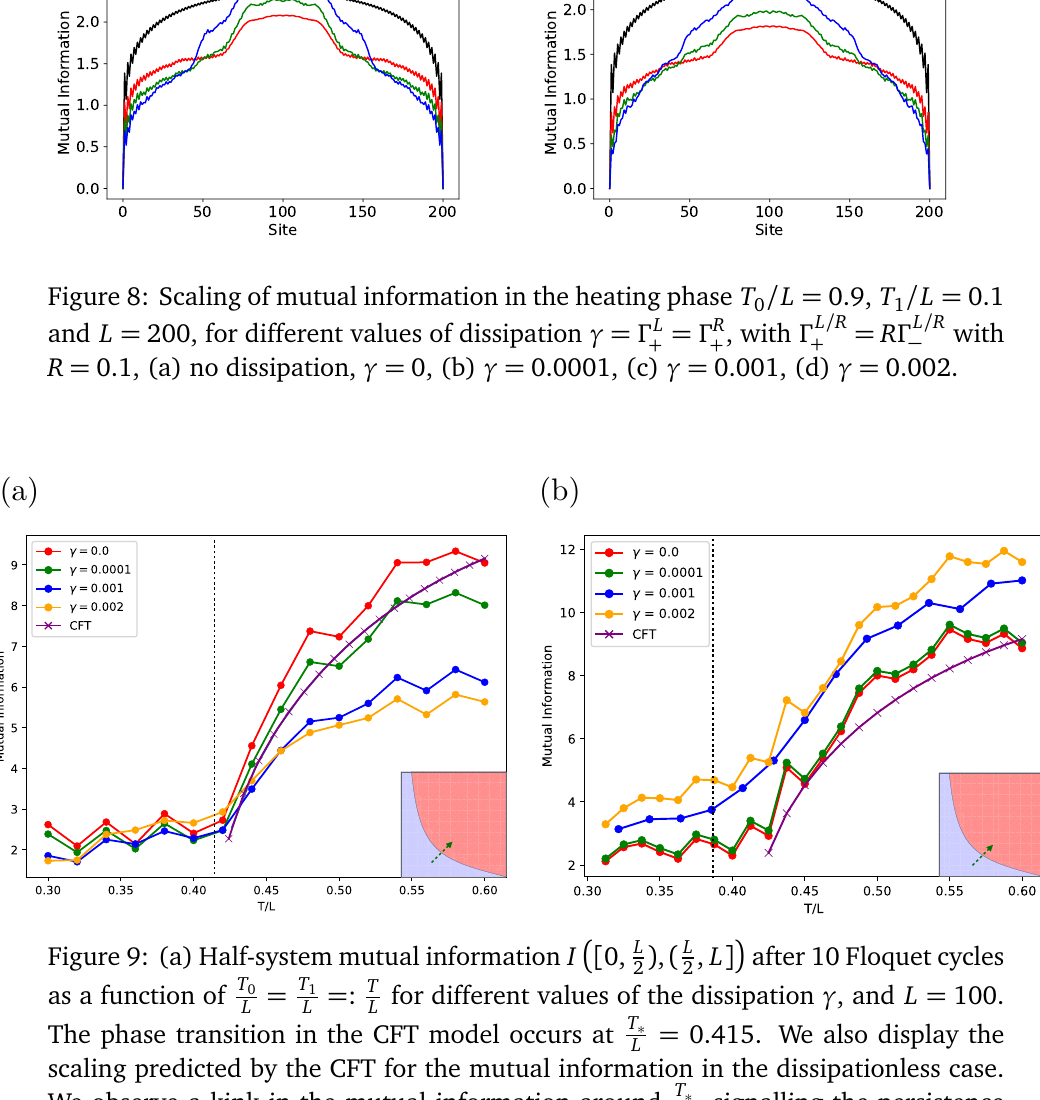
(cid:0) [ (cid:1) ) , ( L Figure 9: (a) Half-system mutual information I 0, L , L ] after 10 Floquet cycles 2 2 = T 1 = : T as a function of T 0 for different values of the dissipation γ , and L = 100. L L L = 0.415. We also display the The phase transition in the CFT model occurs at T ∗ L scaling predicted by the CFT for the mutual information in the dissipationless case. We observe a kink in the mutual information around T ∗ , signalling the persistence L of the heating and non-heating phases in the entanglement structure of the system, even for non-zero dissipation. (b) Same figure but with dephasing instead of particle exchange with the